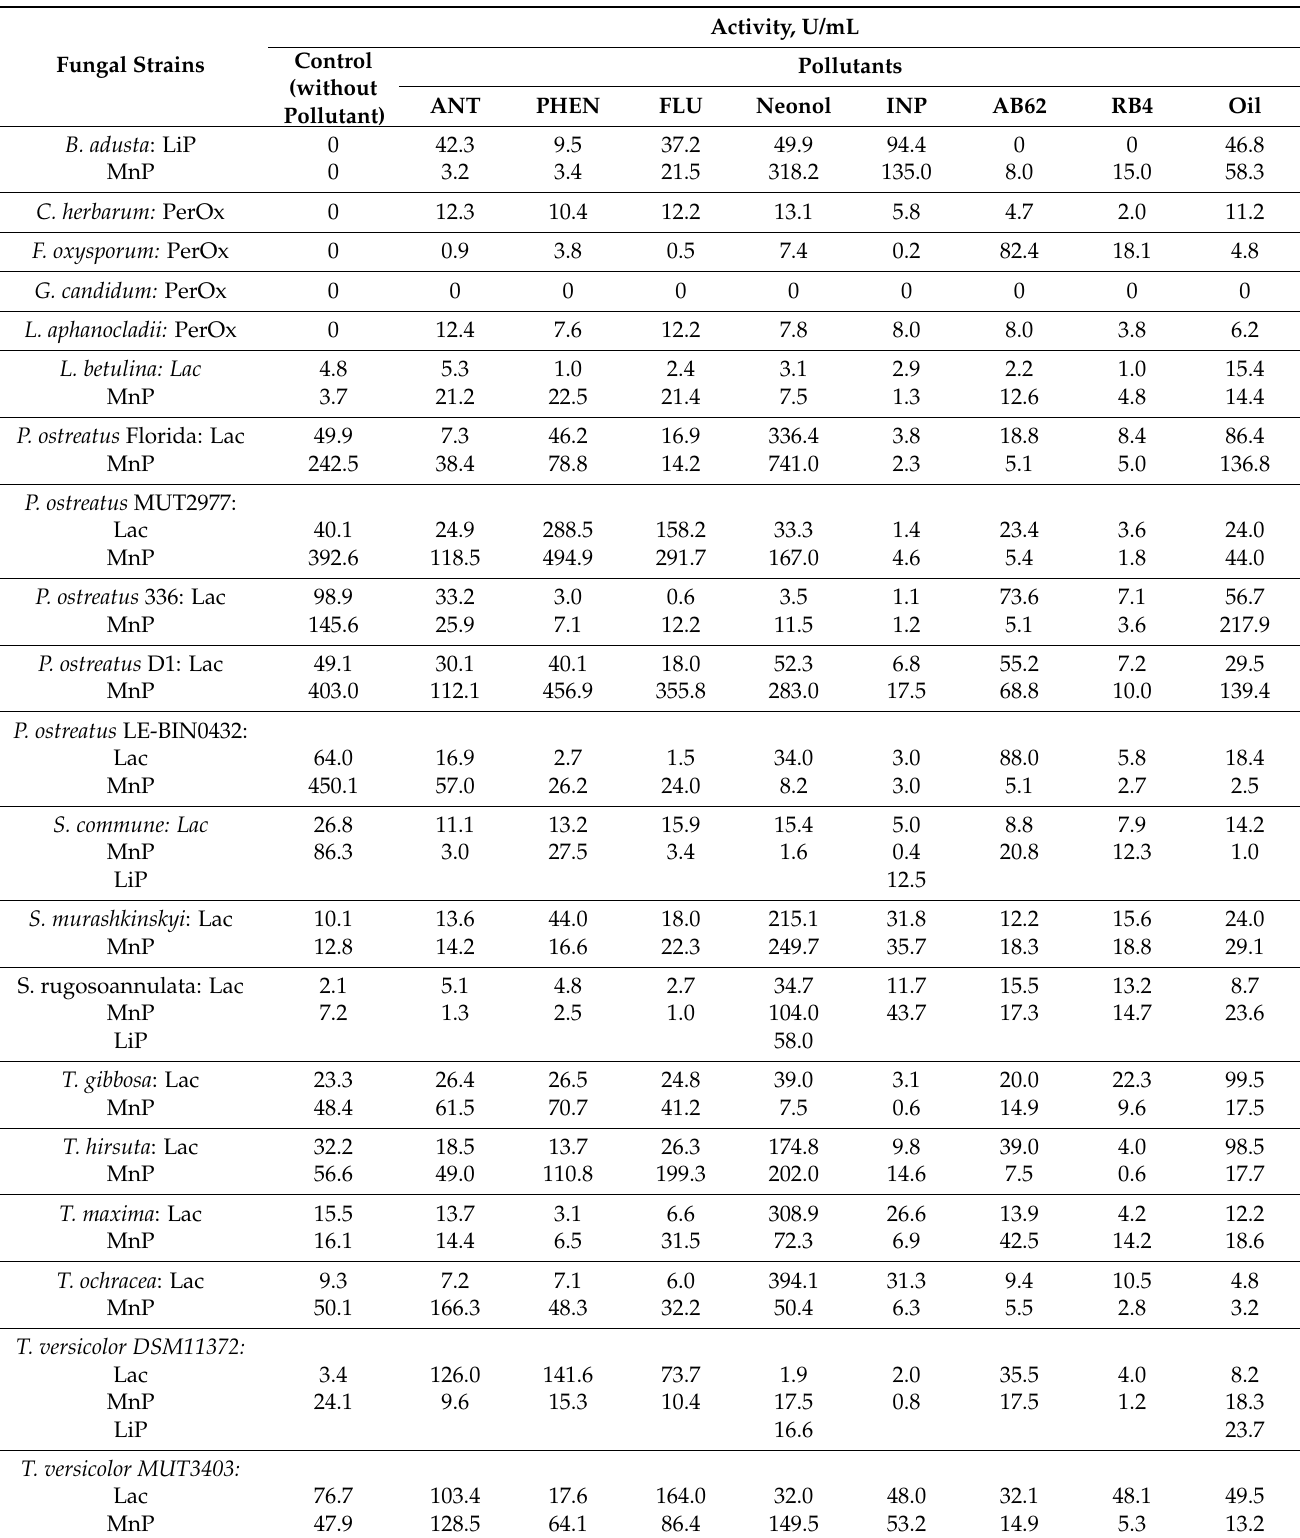
Table 2. Activities of extracellular enzymes (U/mL) after 14 days of the cultivation of the studied fungi both with and without